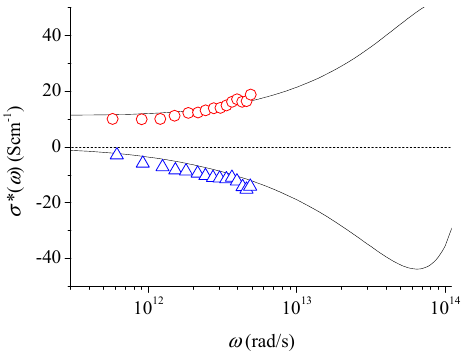
Figure 6. Complex conductivity in nanostructured Sb-doped SnO 2 (( β C 500 P-5%). Open circles and triangles are the experimental data extracted from [29]. Solid lines are predicted conductivity from the SSFTC model.